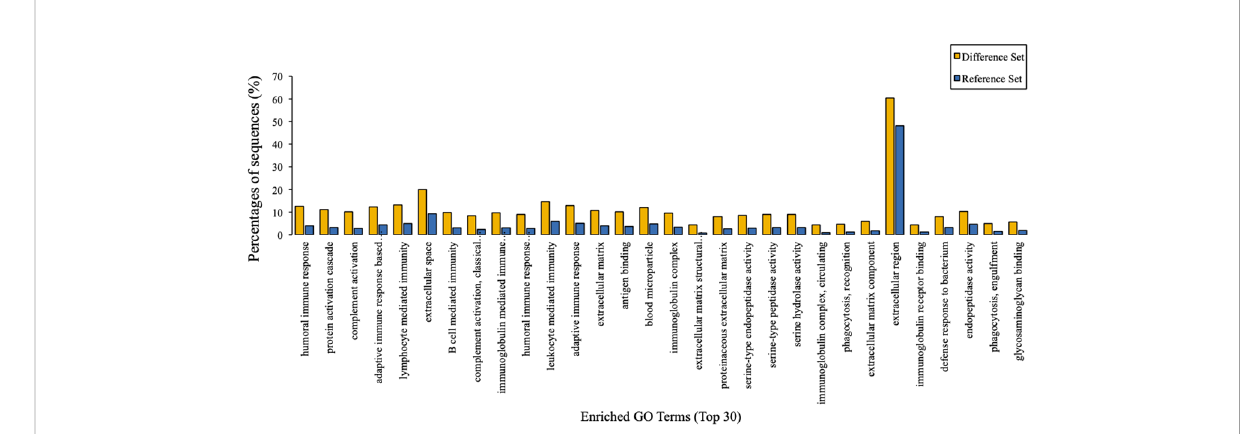
FIGURE 3 GO enrichment analysis results. The top 30 enriched GO terms of target proteins were displayed in comparison with background proteins. Difference set: target proteins; Reference set: background